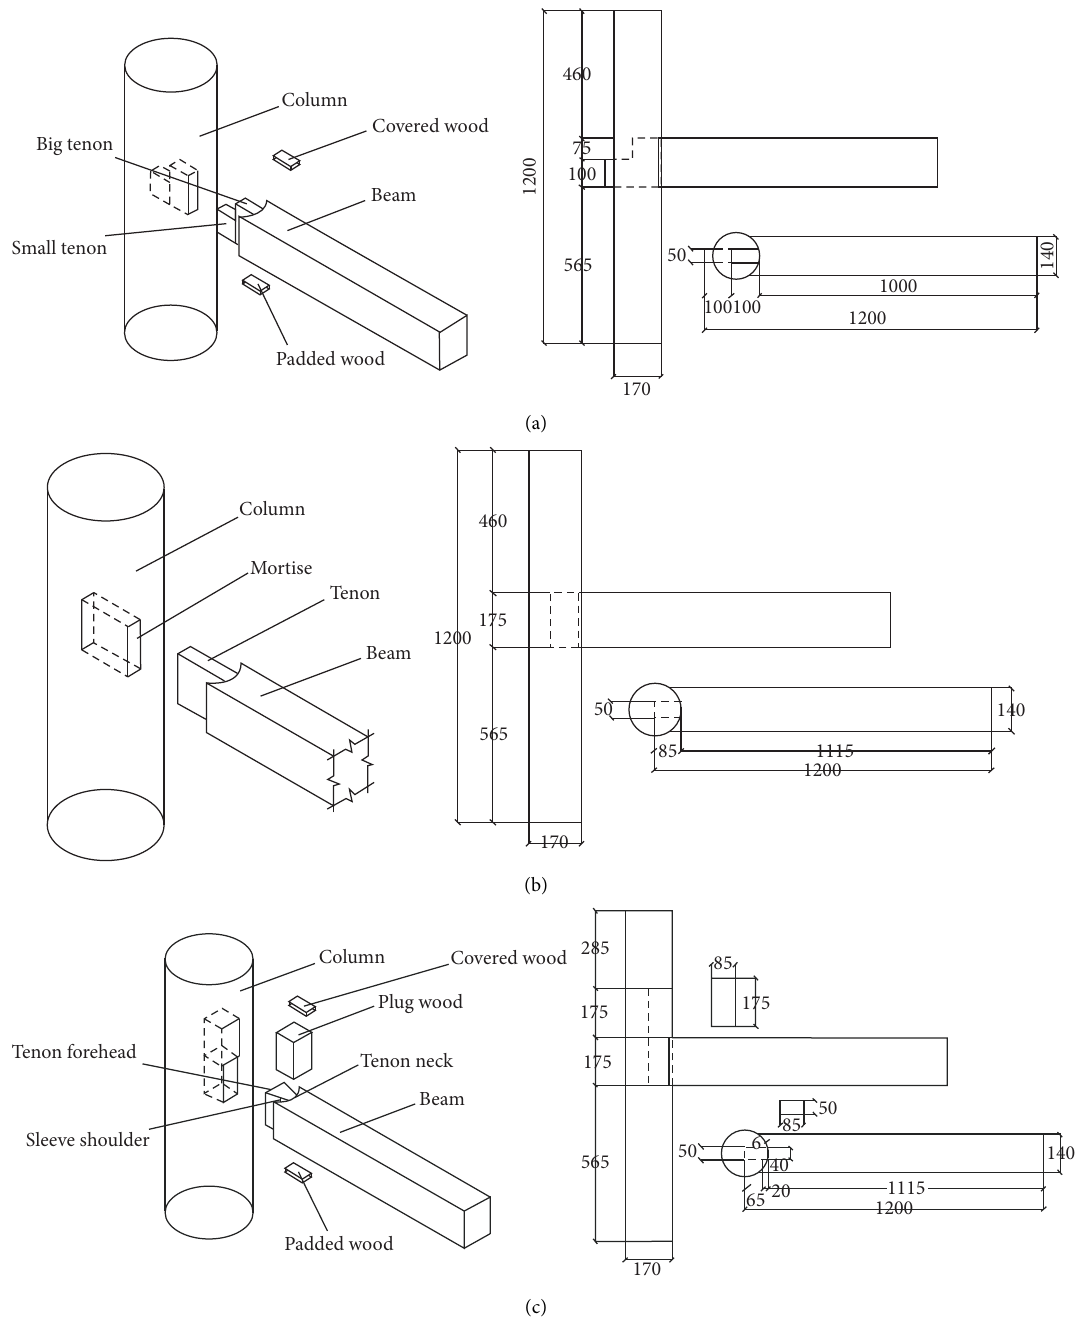
Figure 2: Diagram of mortise-tenon joints: (a) node diagram of Tou mortise-tenon joints. (b) Node diagram of ban mortise-tenon. (c) Node diagram of dovetail mortise-tenon